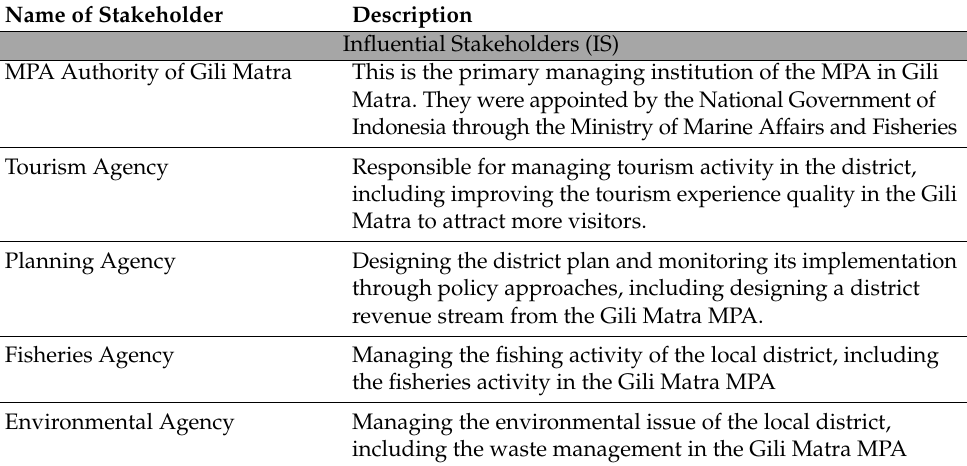
Table 2. Description of each respondent stakeholder in the Gili Matra